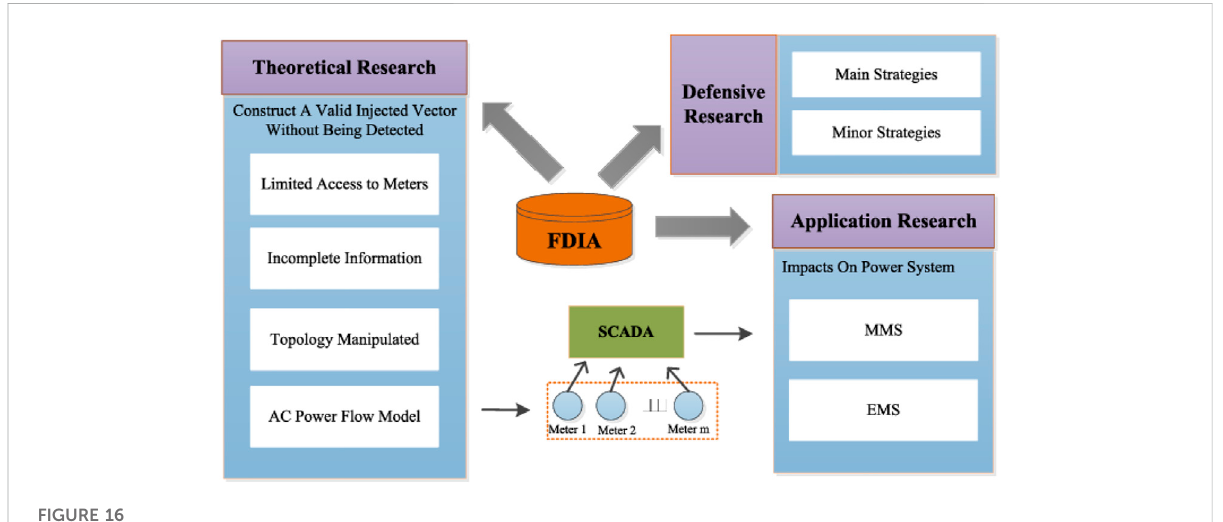
FIGURE 16 False data injection protection